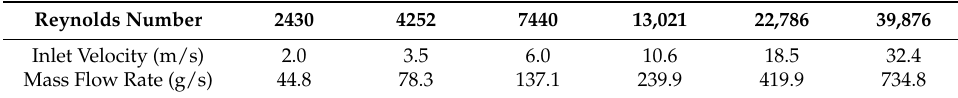
Table 3. Parameters for the Reynolds number study.